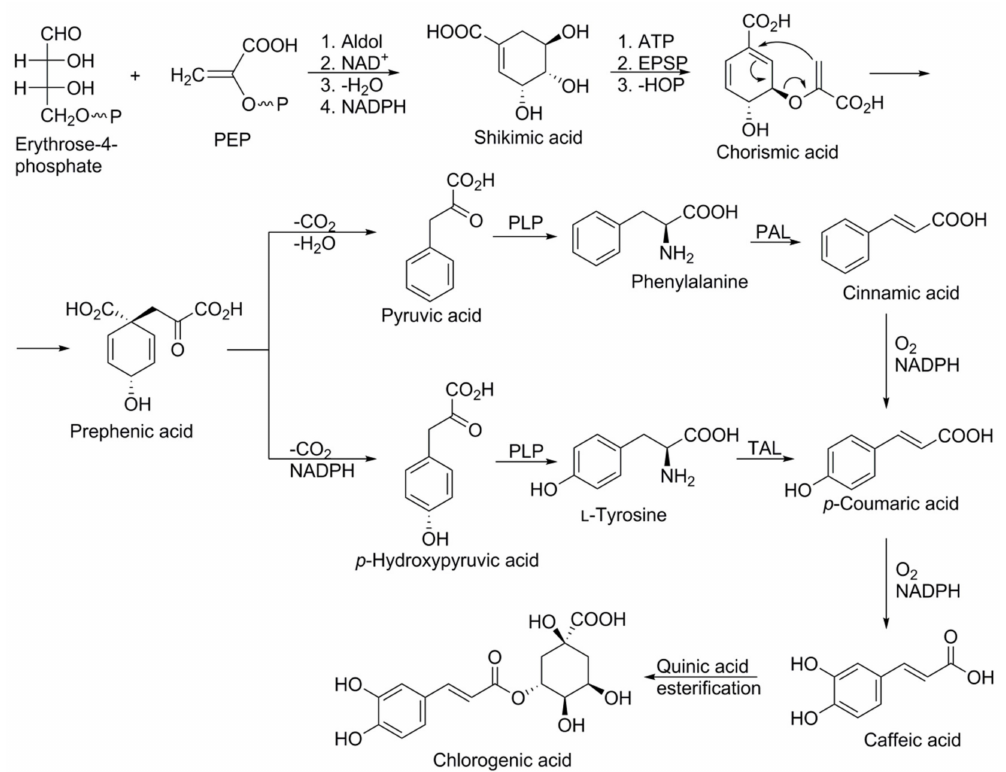
Figure 3. Schematic representation of the biosynthesis of chlorogenic acid via the shikimic